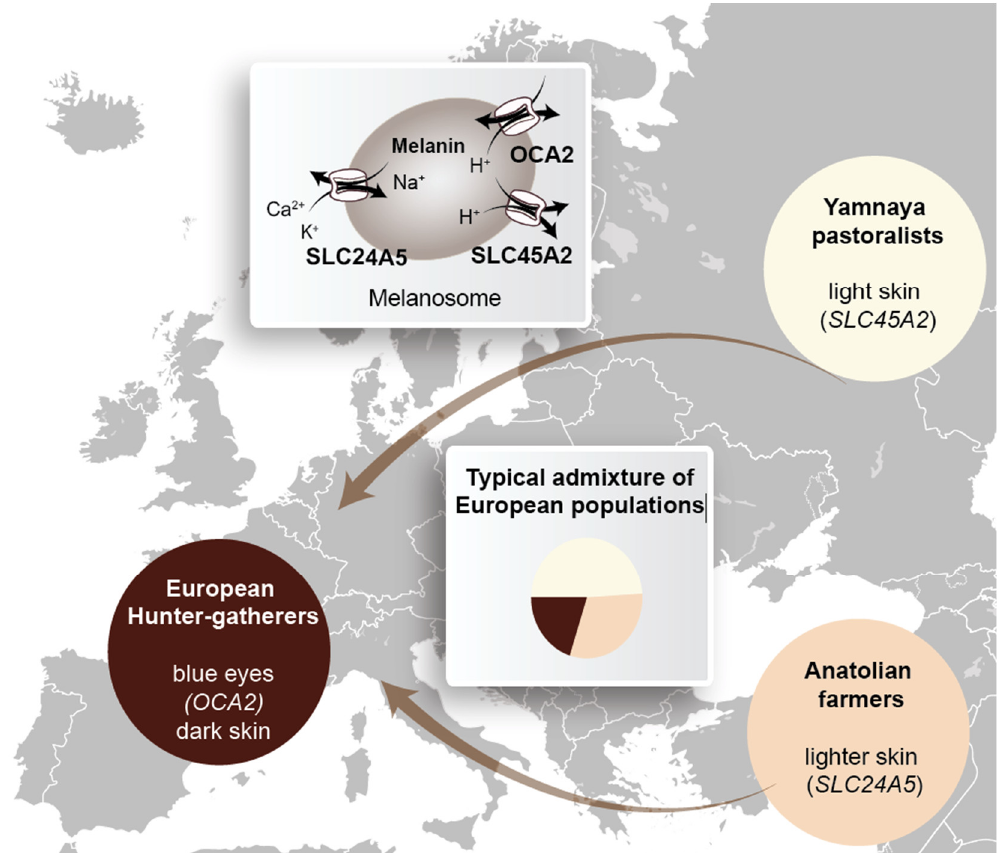
Figure 3. Schematic representation of the admixture of the European population. All European populations derived from European hunter–gatherers, Anatolian farmers and Yamnaya pastoralists [84]. A pie chart indicates the typical admixture of the founding populations ( center ). Melanin is produced in melanosomes under the control of the proteins OCA2, SLC24A5 and SLC45A2 ( top ).